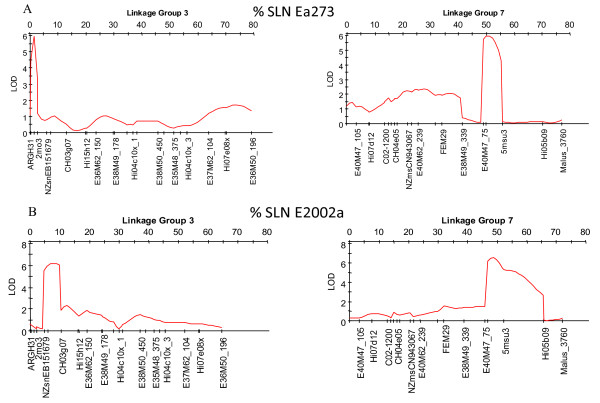
‘Robusta 5’ QTLs for fire blight resistance identified in the ‘Ottawa3’ x ‘Robusta 5’ United States (O3xR5-US) population on Linkage Groups 3 and 7. A) LOD score curves for Multiple QTL Mapping following inoculation with Erwinia amylovora strain Ea273 using MAPQTL 6 (Kyazma, Wageningen, NL) MQM mapping option. B) LOD score curves of Multiple QTL Mapping following inoculation with Erwinia amylovora strain E2002a using MAPQTL 6 (Kyazma, Wageningen, NL) MQM mapping option.